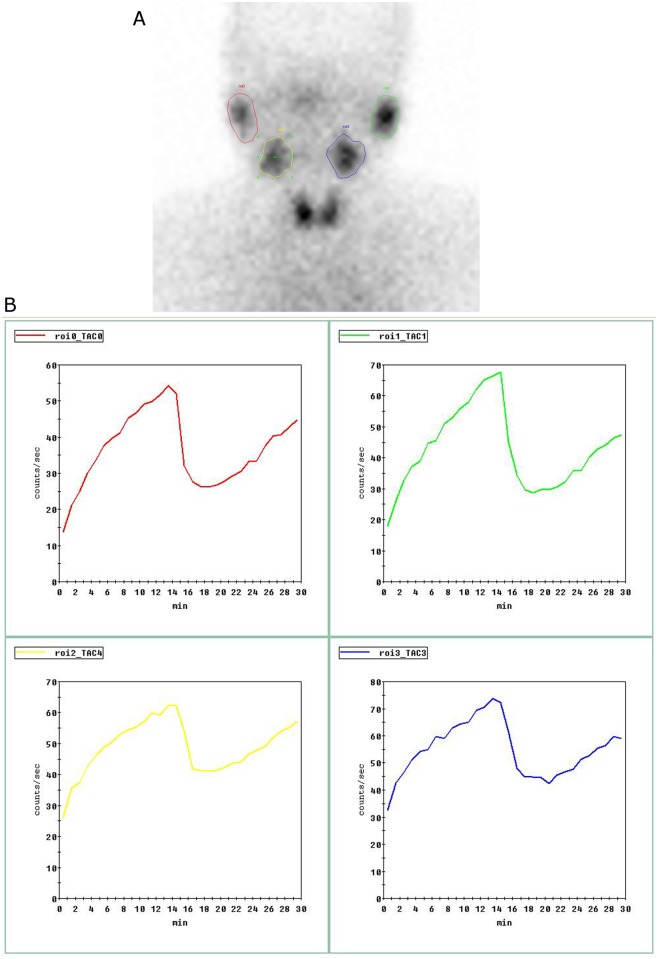
Regions of interest (ROIs) in SPECT imaging of salivary gland (SSG).The images of bilateral parotid and submandibular glands at 14min postinjection of radiotracer in the left panel (a). The time-activity curves for right parotid gland (red), left parotid gland (green), right submandibular gland (yellow) and left submandibular gland (blue) in the right panel (b).